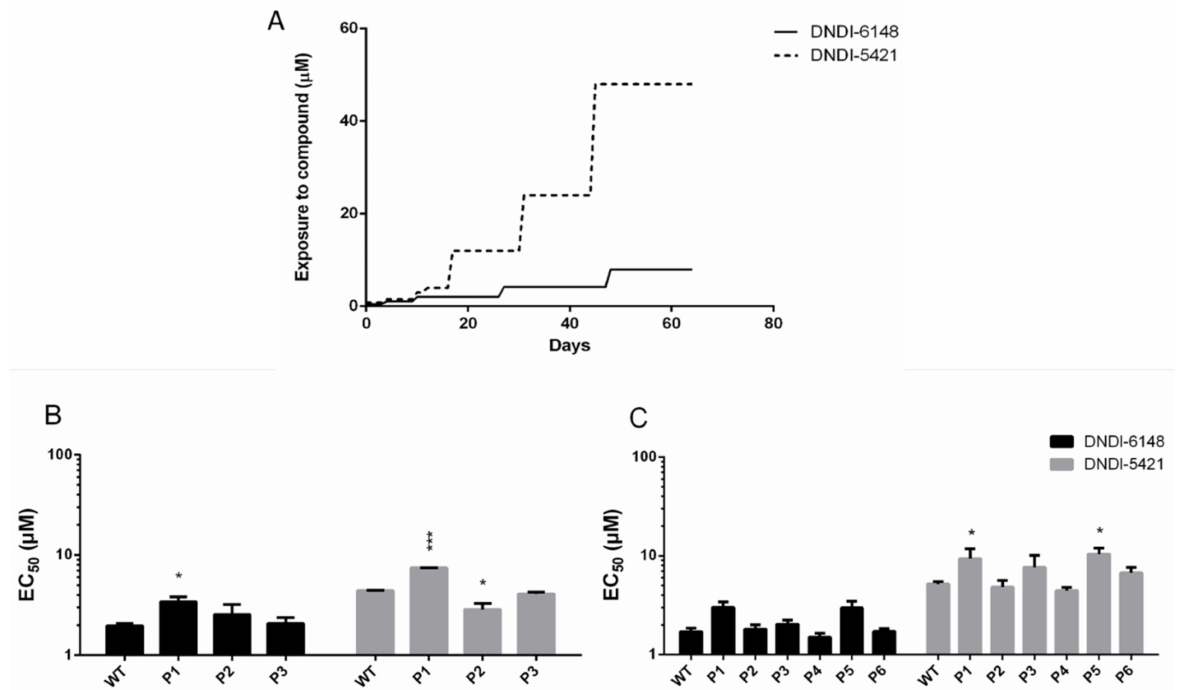
Figure 1. Overview of the stepwise generation of resistant parasite lines toward two oxaboroles ( A ). Comparison of the in vitro susceptibility in the extracellular promastigote assay of the wild-type Scheme 6148 ( B ) and DNDI-5421 ( C ). Results are expressed as the mean EC 50 ( µ M) ± SEM, and are based on two biological replicates, each comprising two technical replicates (* p < 0.05, *** p <